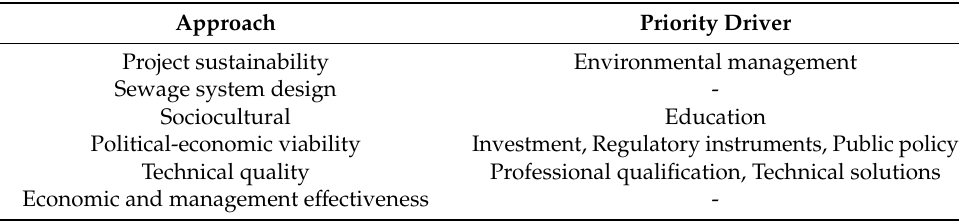
Table 4. Priority drivers grouped by the